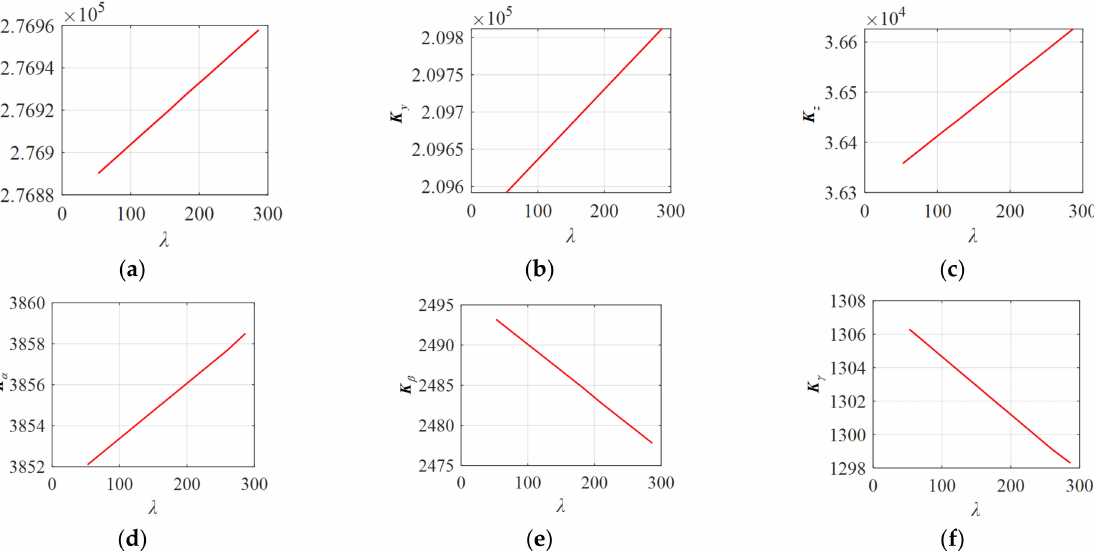
Figure 10. The relationship between the stiffness and λ in the direction of six degrees of freedom in space: ( a ) the relationship between the stiffness along the x -axis and λ , with a slope of 0.2838; ( b ) the relationship between the stiffness along the y -axis and λ , with a slope of 0.9204; ( c ) the relationship between the stiffness along the z -axis and λ , with a slope of 1.1218; ( d ) the relationship between the torsional stiffness around the x -axis and λ , with a slope of 0.0268; ( e ) the relationship between the torsional stiffness around the y -axis and λ , with a slope of − 0.0645; ( f ) the relationship between the torsional stiffness around the z -axis and λ , with a slope of − 0.0335.